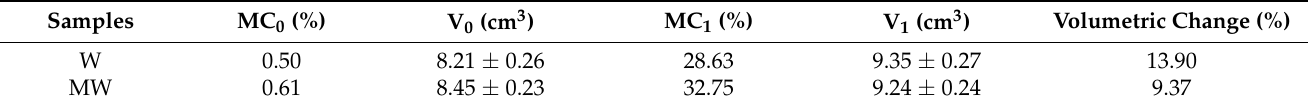
Figure 5. ( a ) The moisture absorption expansion rate and moisture absorption anti-swelling efficiency of the wood block, ( b ) the water absorption expansion rate and water absorption anti-swelling efficiency of wood block, and ( c ) the P w and P v of PMP during the three-cycle immersion test. Table 1. Volumetric change of wood samples under different moisture